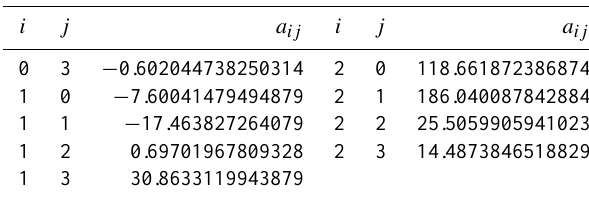
Table A1. Coefficients of the auxiliary critical equation of state, Eq.